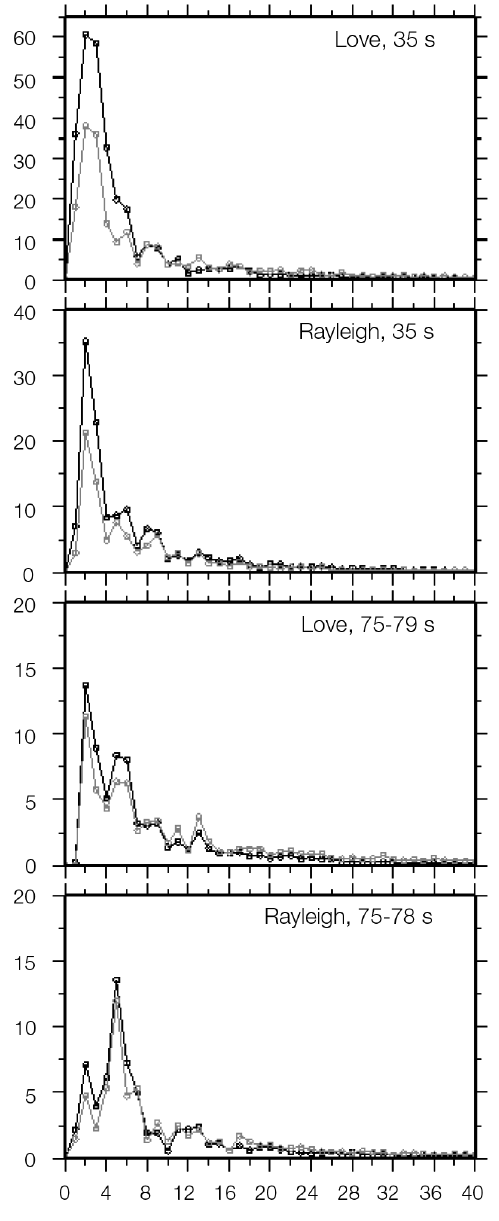
Fig. 2. Spherical harmonic spectra of the maps from fig. 1. The spectra of maps derived from Utrecht data are plotted in grey; the black curves are the spectra of the corresponding maps, derived from Harvard